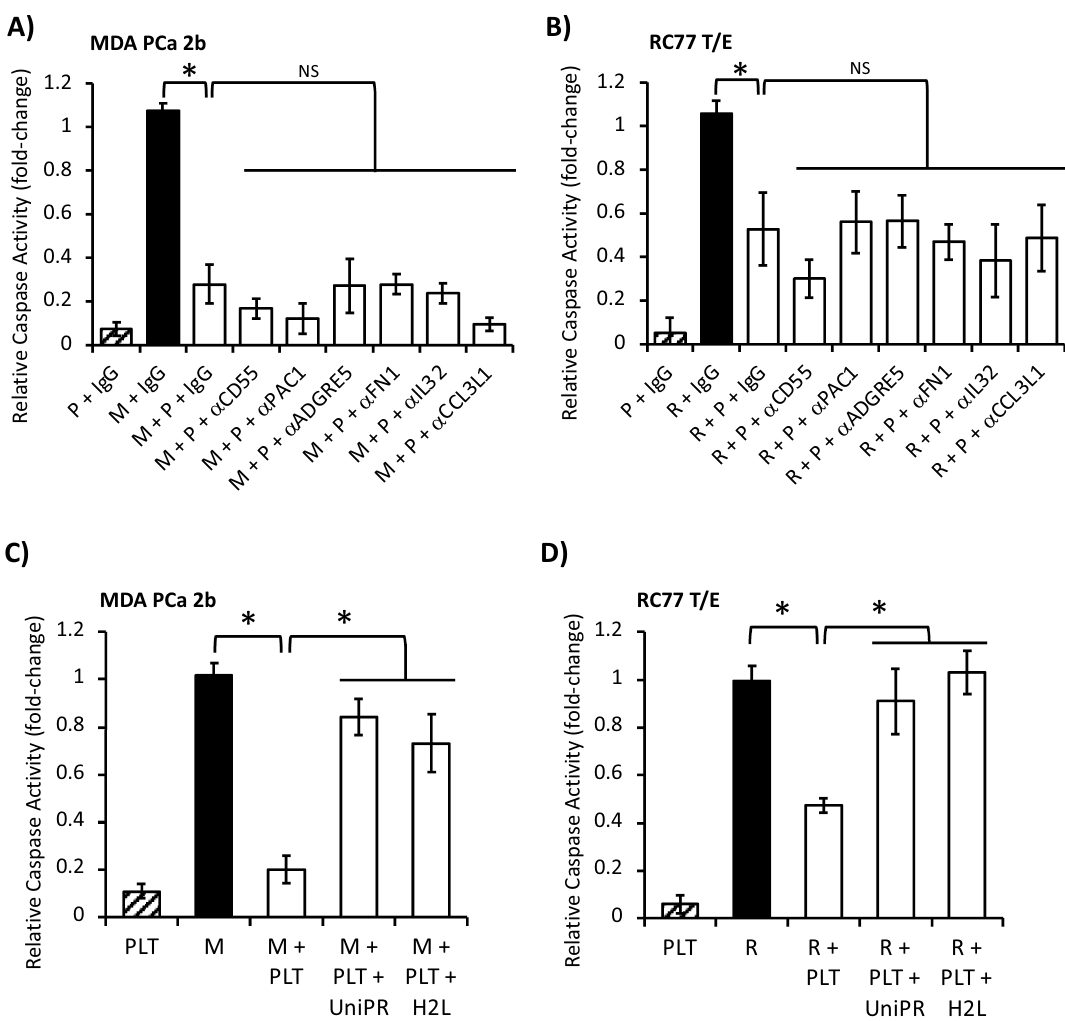
Figure 7. Ephrin-EPH receptor and LPA-LPAR signaling axes participate in platelet-induced PCa cell apoptotic resistance. ( A , B ) Platelet (P)-induced MDA PCa 2b (M) and RC77 T/E (R) apoptotic resistance was examined in the presence of IgG isotype control (5 µg/ml) or the indicated blocking antibodies (α; 5 µg/ml). Cell:platelet ratio was 1:1000. Data presented as the mean ± SEM of n = 4–8 independent determinations and analyzed by ANOVA and Tukey post-hoc test, * P < 0.05. ( C , D ) Platelet-induced MDA PCa 2b and RC77 T/E apoptotic resistance was examined in the absence or presence of pan-receptor subtype inhibitors UniPR1331 (UniPR; 10 µM) and H2L 5765834 (H2L; 10 µM) to uncouple the ephrin-EPH receptor and LPA-LPAR axes, respectively. Cell:platelet ratio was 1:1000. Control indicates PCa cells in the absence of platelets and treated with vehicle. PLT indicates addition of platelets to PCa cells. Data presented as the mean ± SEM of n = 3–6 independent determinations and analyzed by ANOVA and Tukey post-hoc test, * P <